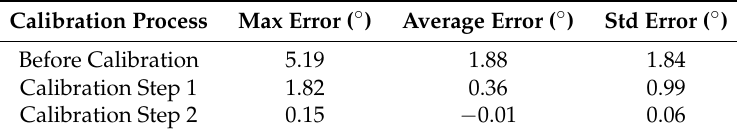
Figure 8. Orientation errors in the calibration process. Table 1. Angle estimation errors of the indoor calibration